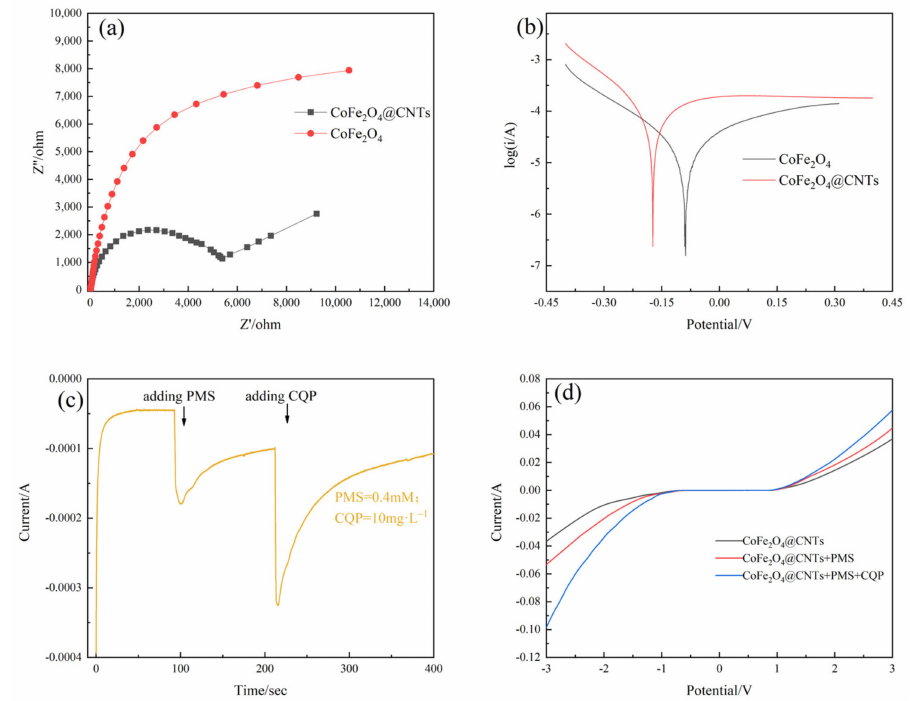
Figure 17. ( a ) EIS Nyquist plots of CoFe 2 O 4 and CoFe 2 O 4 @CNTs; ( b ) Tafel polarization curves of CoFe 2 O 4 and CoFe 2 O 4 @CNTs composite; ( c ) the current curve measurements upon the addition of PMS and CQP with CoFe 2 O 4 @CNTs; ( d ) the linear sweep voltammetry (LSV) of CoFe 2 O 4 @CNTs, CoFe 2 O 4 @CNTs/PMS and CoFe 2 O4@CNTs/PMS/CQP